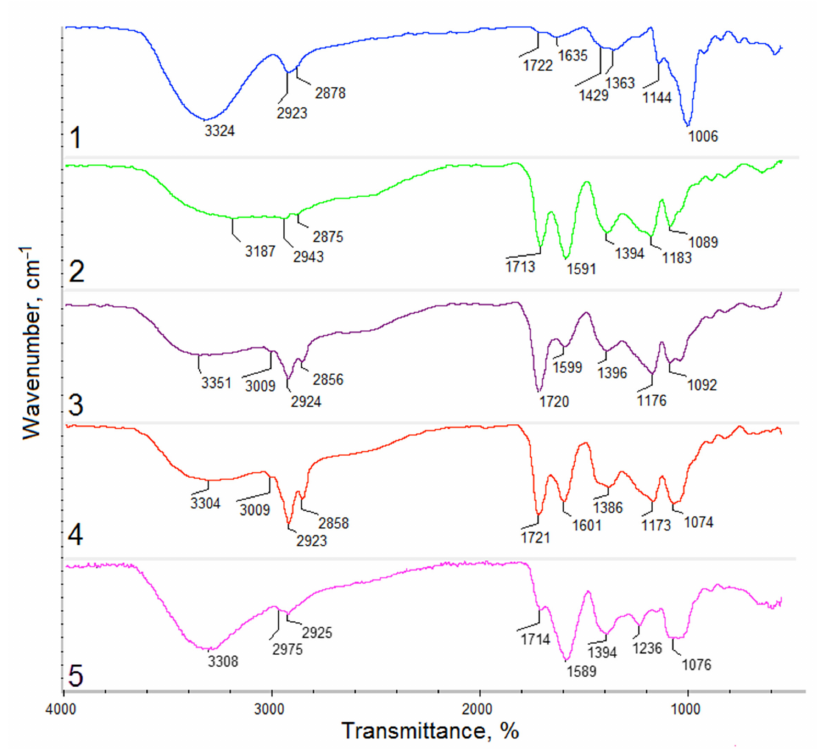
Figure 3. FTIR spectra of ( 1 ) Kalanchoe pinnata leaf; ( 2 ) commercially available extract; ( 3 ) plant extract prepared using 50% ethanol solution; ( 4 ) plant extract prepared using 95% ethanol solution; ( 5 ) plant extract prepared using 95% ethanol solution and